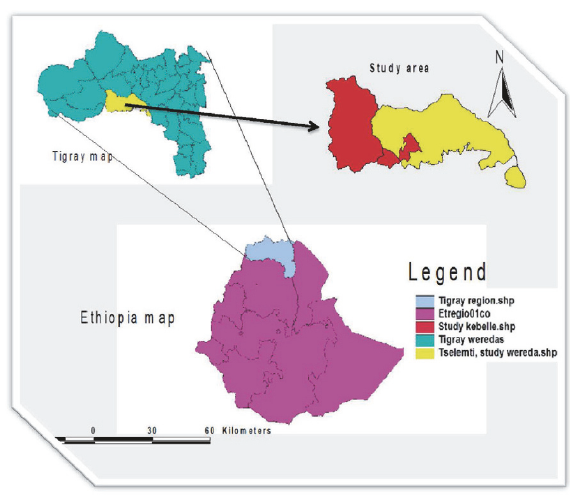
Figure 1: Location of the study area.